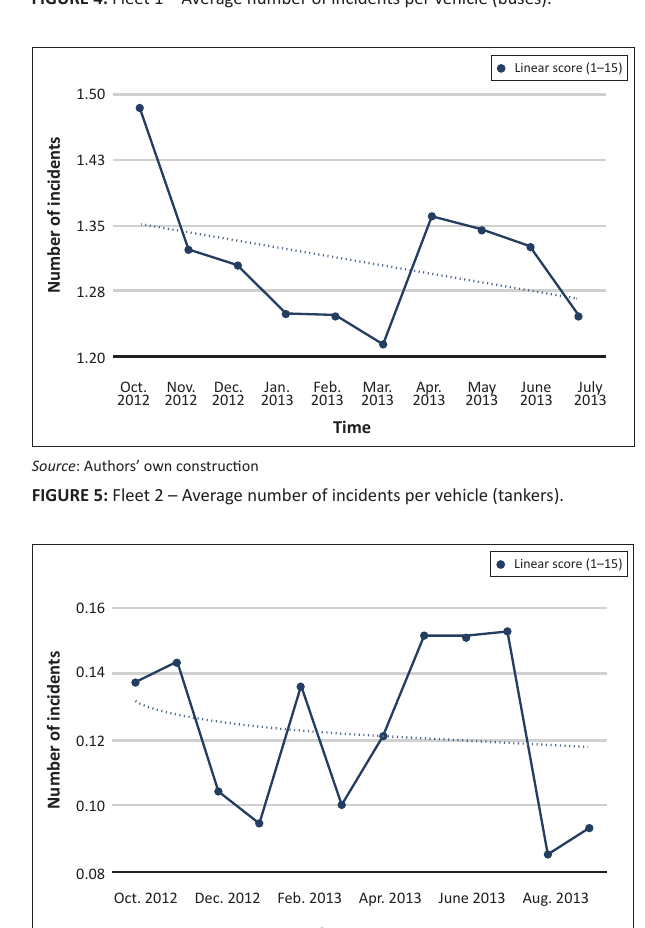
FIGURE 4: Fleet 1 – Average number of incidents per vehicle (buses).